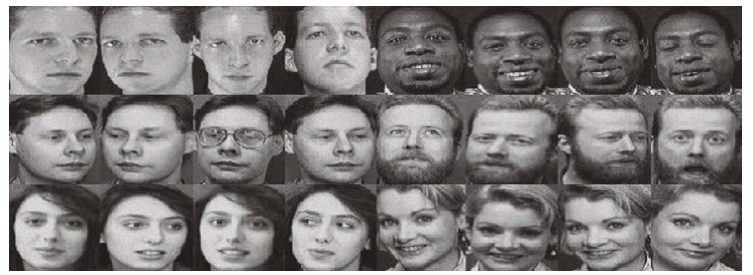
Figure 6. Example of six different subjects (each with 4 images) from the ORL database [56].